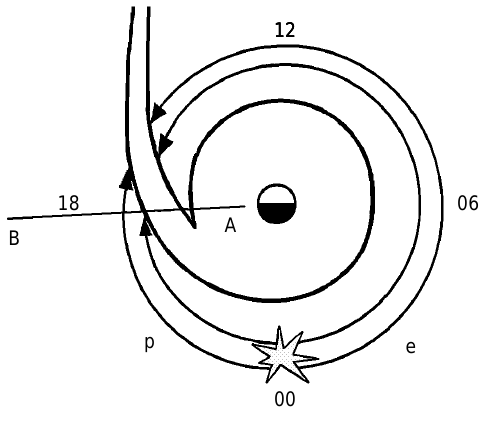
Fig. 10. Schematic presentation showing the interaction of longi- tudinally drifting energetic particles and the ‘‘tongue’’-like cold plasma structure formed during storm time on the dusk side of the